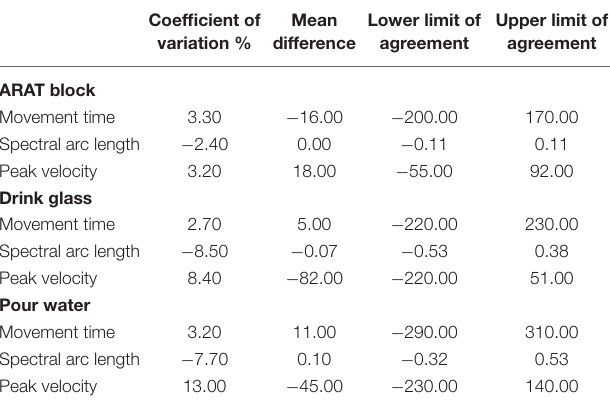
TABLE 2 | Measurement differences between the outREACH sensor and Vicon